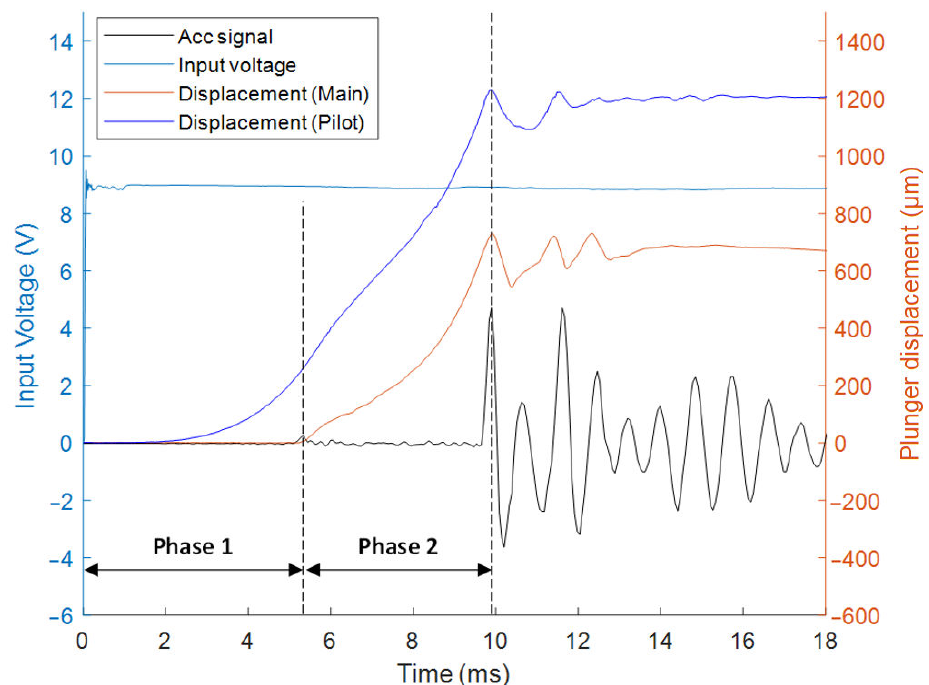
Figure 5. Measured displacements of the pilot plunger and main plunger along operation of the solenoid